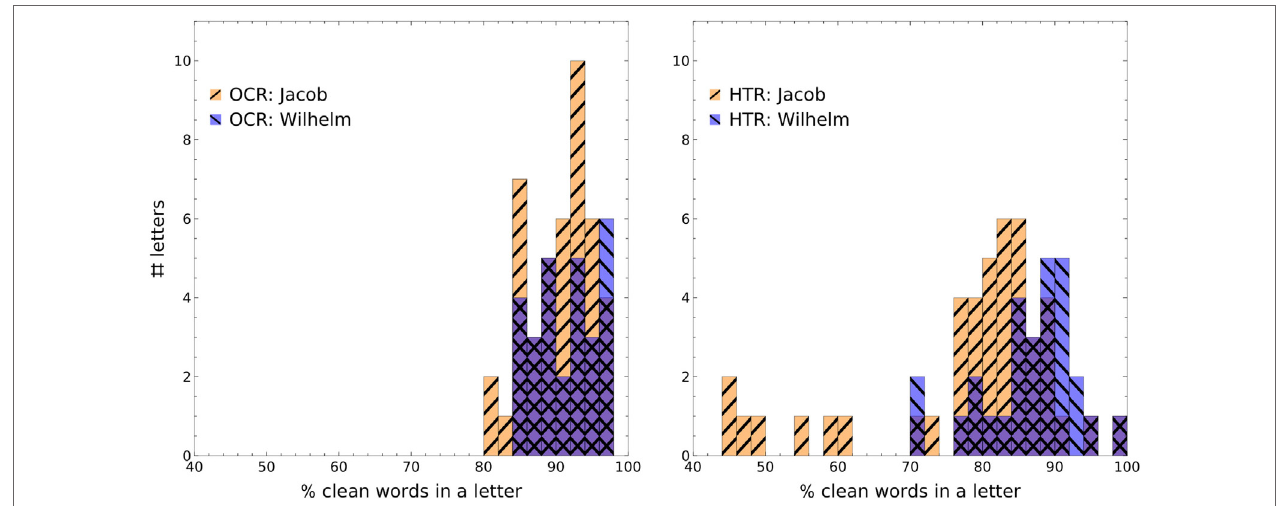
FigUre 5 | Histograms of letters divided by Jacob and Wilhelm. The right panel shows that it was Jacob’s writing that was more problematic for